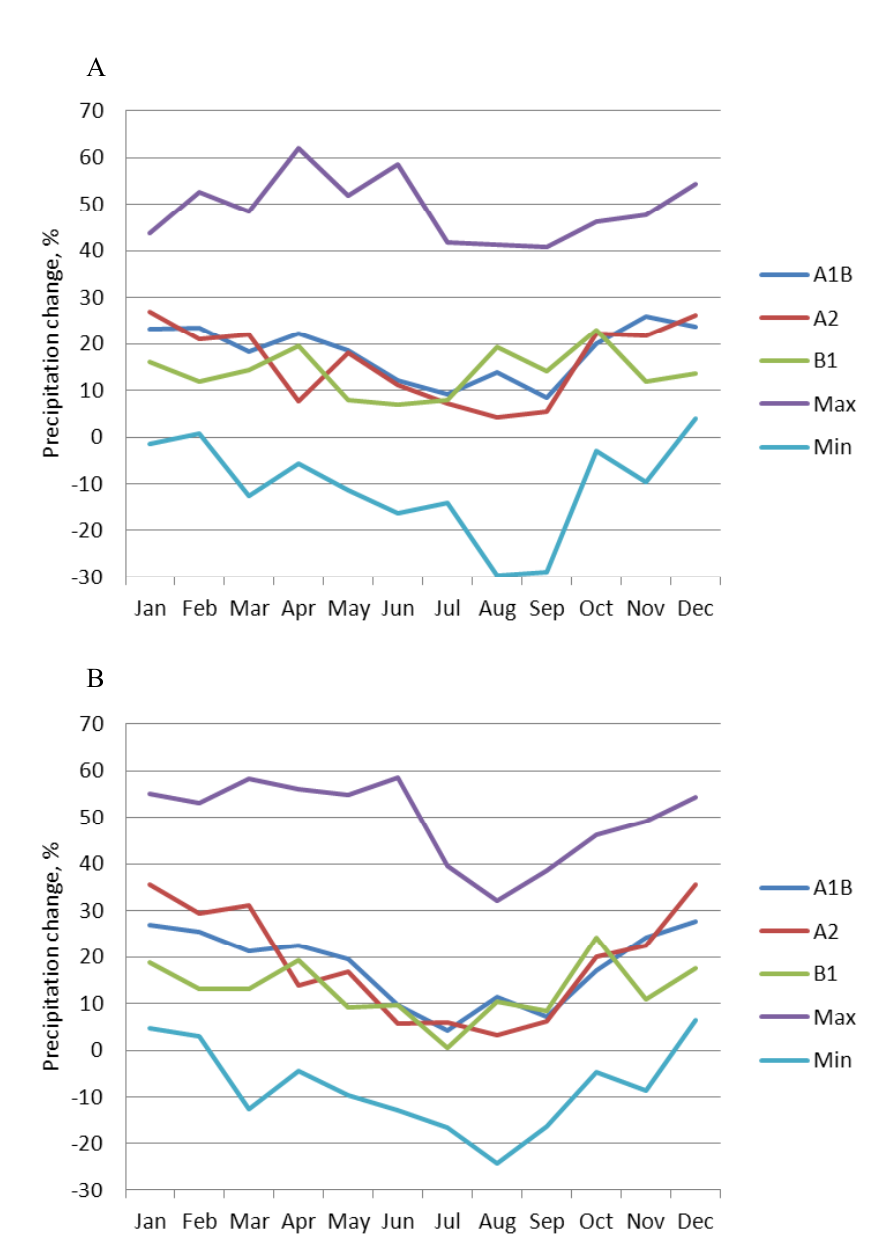
Fig. 6. Multi-model mean annual curves of monthly mean precipitation changes (in comparison with the 1961(cid:150)1990 baseline period) in western Estonia ( A ) and in eastern Estonia ( B ) for 2070(cid:150)2099 using three SRES emission scenarios and 12 selected GCM outputs from AR4 together with the absolute maximum and minimum estimates of these GCMs.